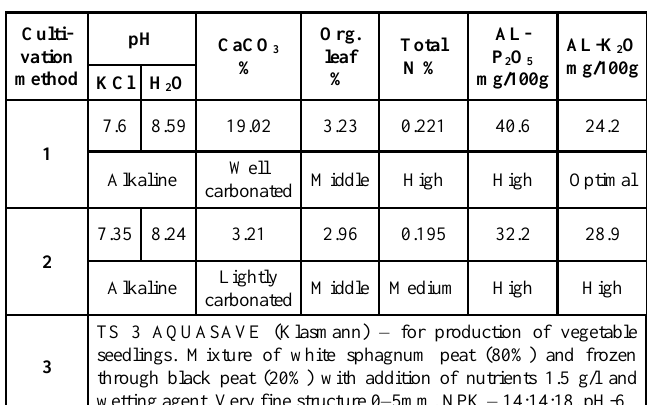
Table 1. The soil parameters of the test strawberry orchard in